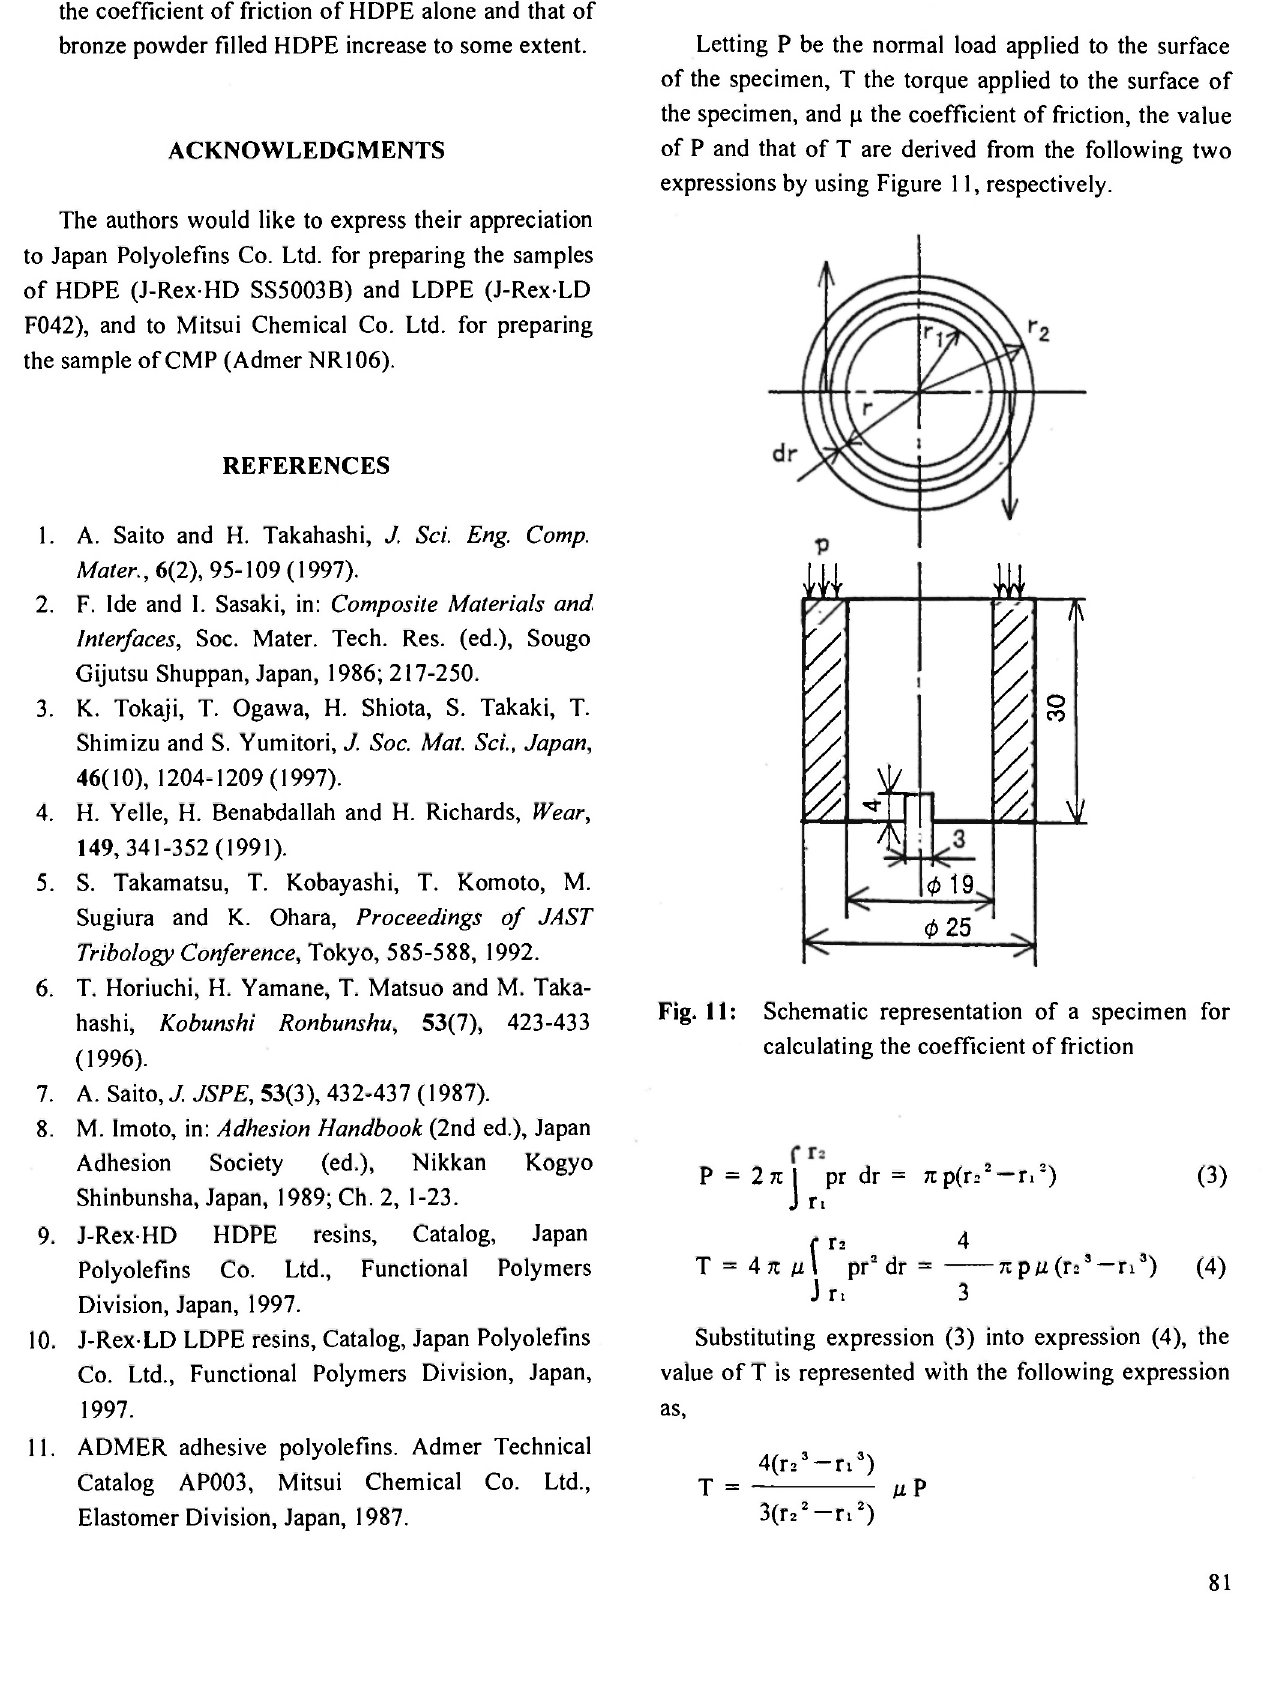
Fig. 11: Schematic representation of a specimen for calculating the coefficient of